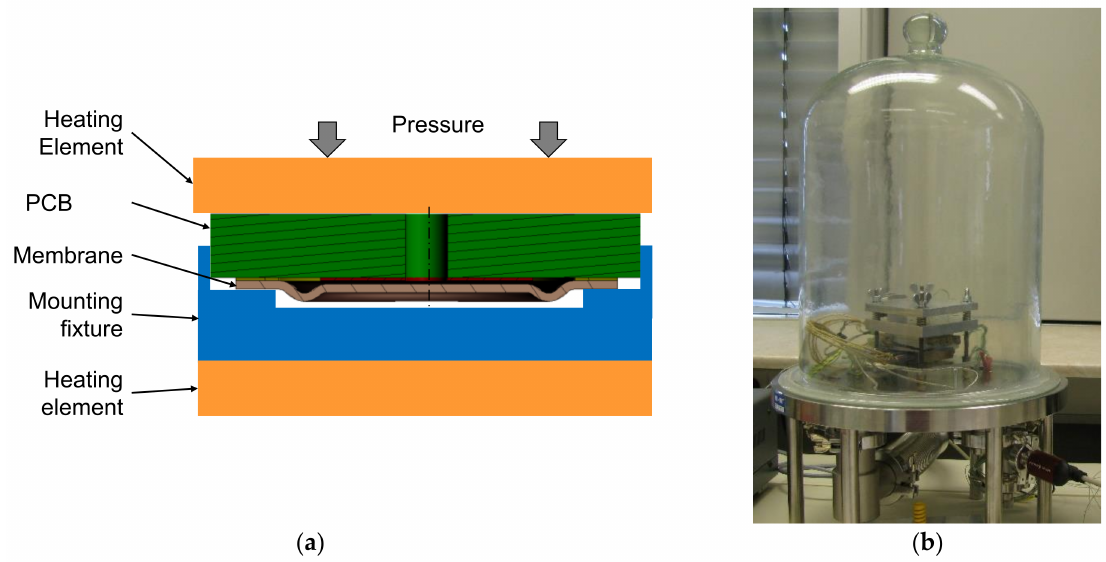
Figure 5. TLP bonding process: ( a ) cross-section sketch; ( b ) apparatus for TLP bonding in vacuum used in this